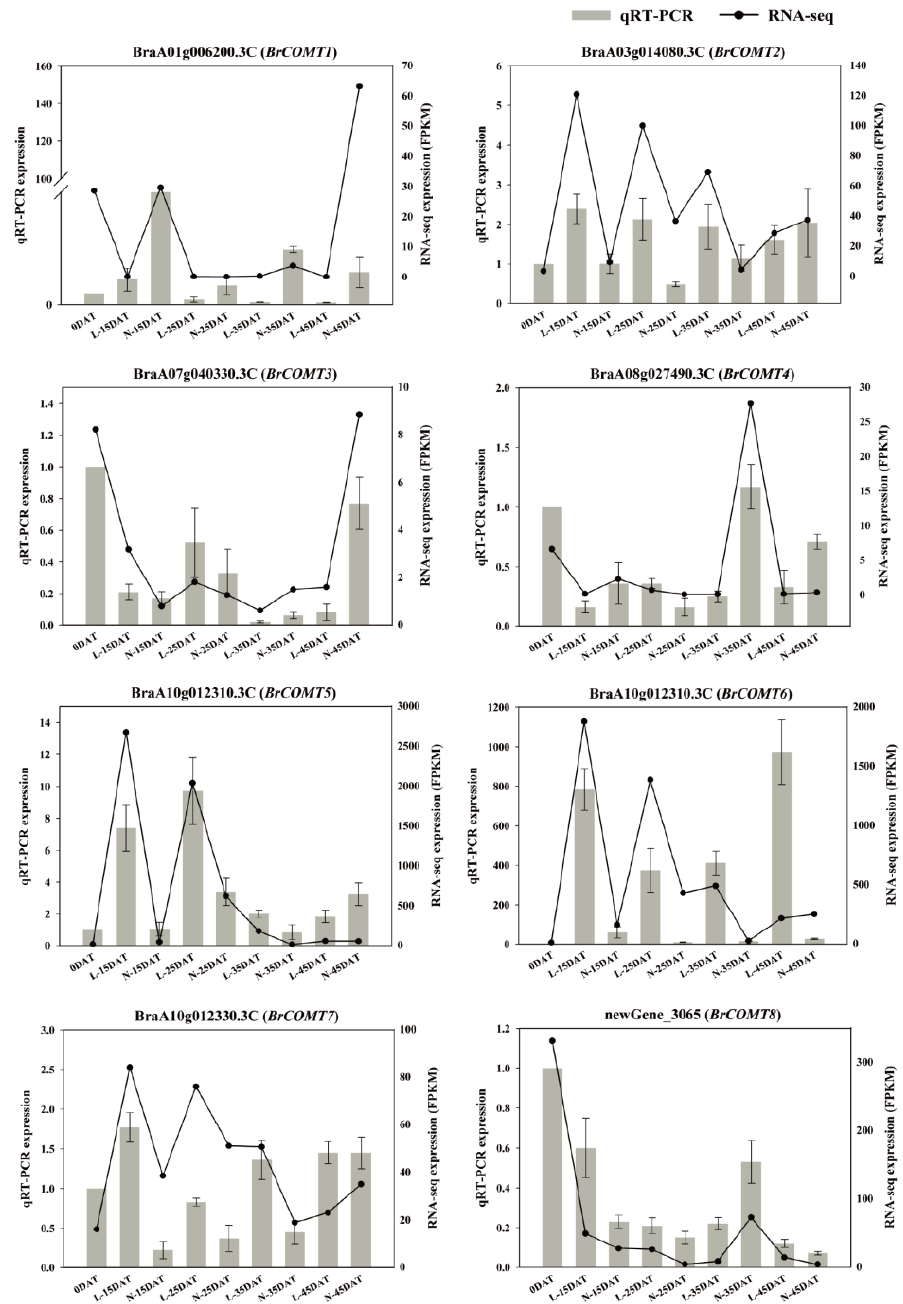
Figure 9. qRT-PCR was performed using 8 DEGs of COMT genes. Bar and line graphs represent the qRT-PCR and RNA-seq data, respectively. Data are presented as the mean ± standard error (SE).